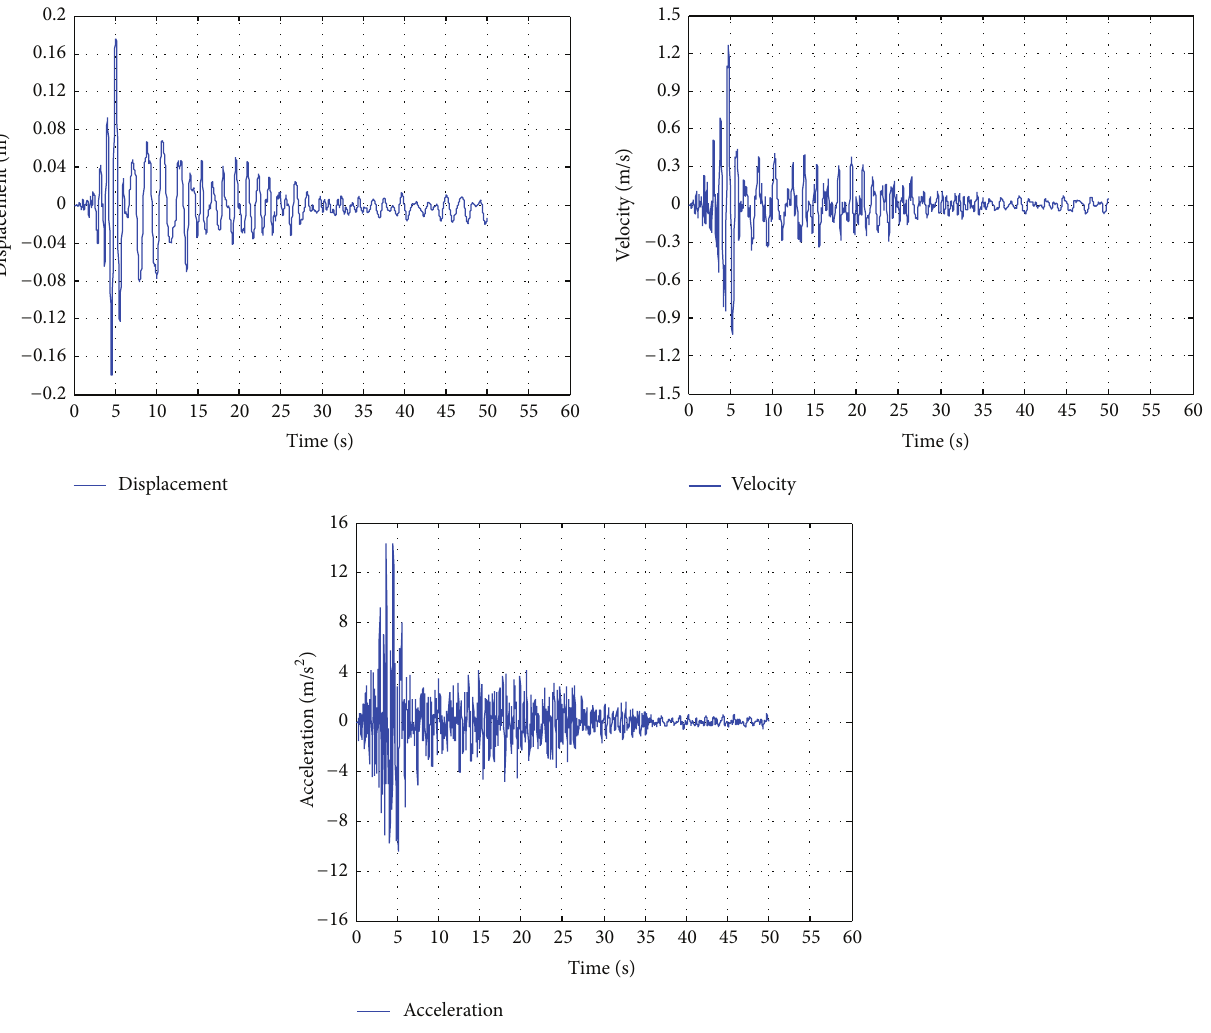
Figure 8: Dynamic responses of the middle foundation ( 𝑉 𝑤 = 200 m/s).